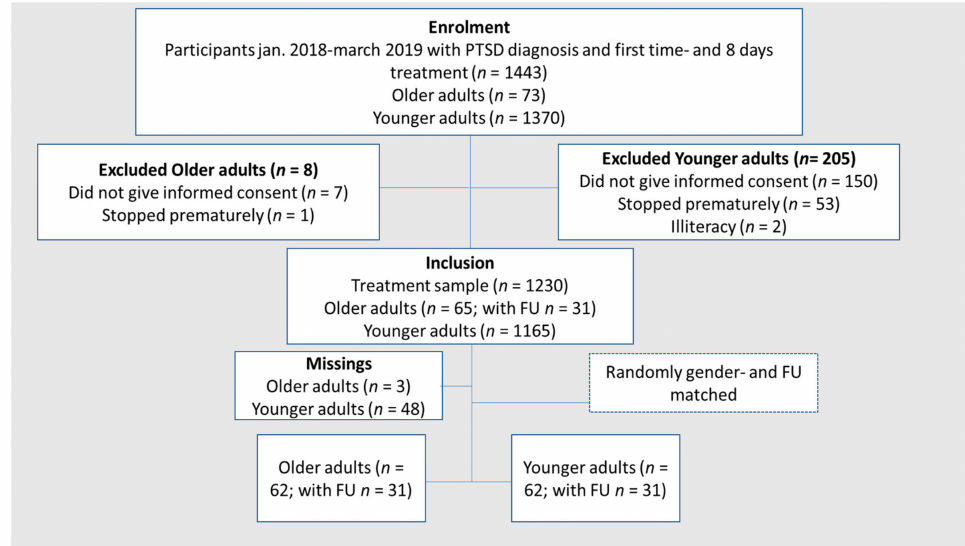
Figure 1. Flowchart of